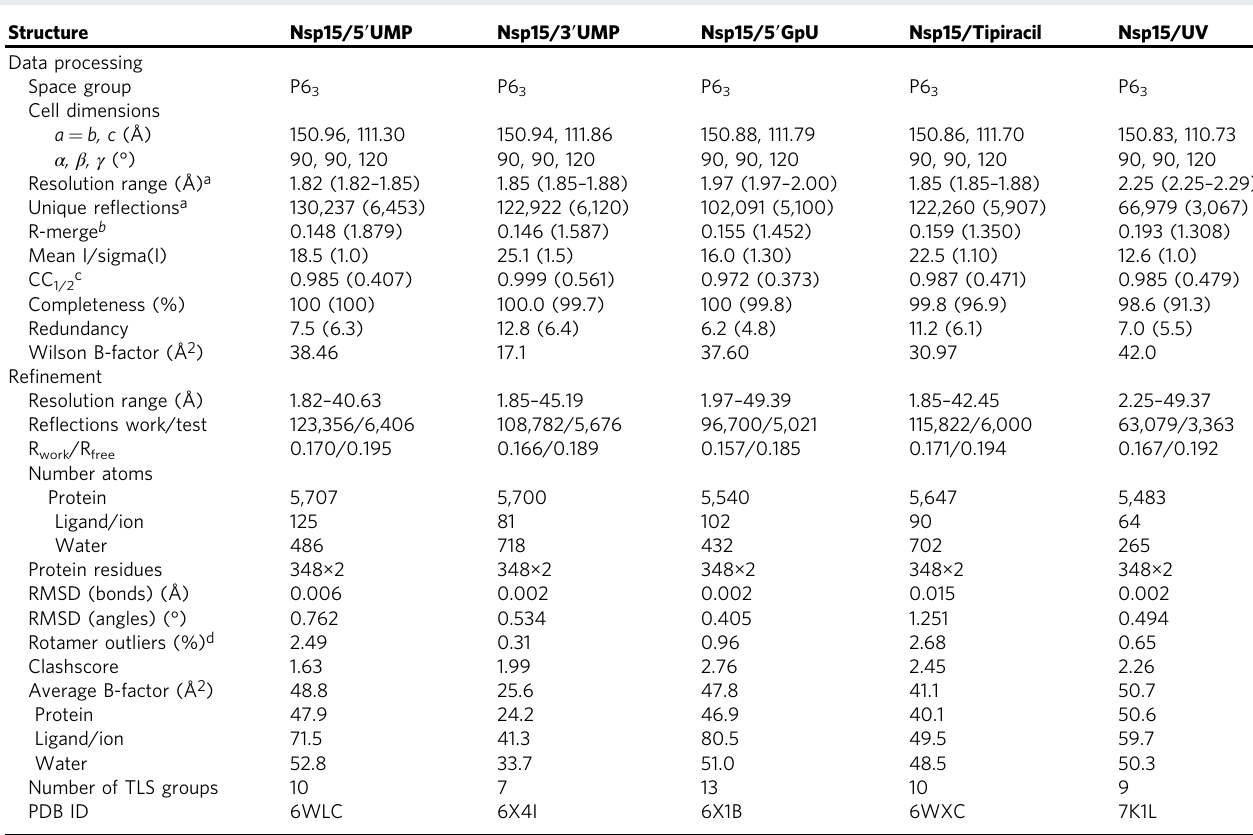
Table 1 Data processing and re fi nement